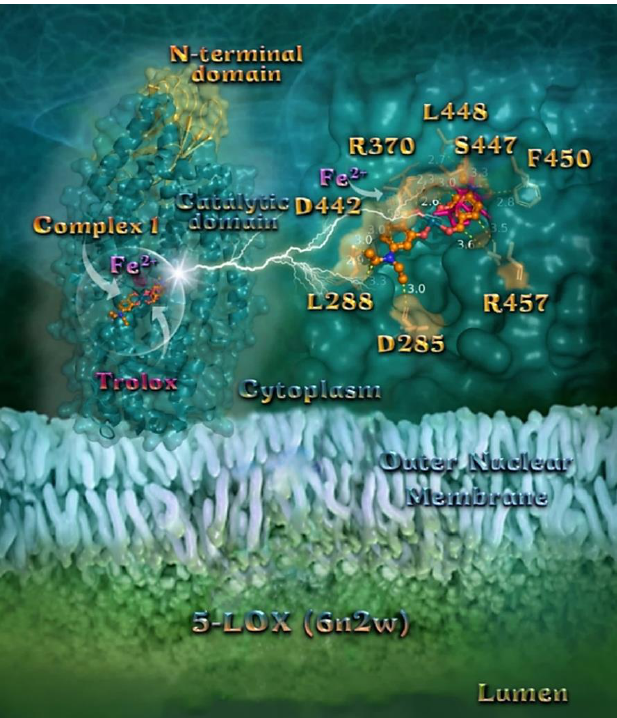
Figure 10. ( Left panel ) Docking pose orientation of complex 1 in the crystal structure of 5-LOX bound with the redox-type inhibitor NDGA (PDB: 6n2w). The target protein is illustrated as a semi-transparent surface in deep teal (catalytic domain) and yellow-orange (N-terminal domain). In superposition are shown the lowest Δ G bind energy binding pose of 1 , as well as the co-crystallized inhibitor NDGA and Trolox, rendered in a ball-and-stick model ( 1 ) and stick (NDGA and Trolox) and colored according to atom type in orange, white, and hot pink C atoms, respectively. Fe 2+ is indicated as a violet dotted sphere. Molecular protein structure is shown to be anchored in the outer nuclear membrane colored in a light blue/green model. ( Right panel ) A close-up view of the binding pocket of 1 in the crystal structure of 5-LOX bound with Trolox (6n2w). The target protein is depicted as a semi-transparent deep teal surface with the additional depiction of selected contacting residues of the binding pocket highlighted in yellow-orange. Complex 1 and Trolox are rendered in ball-and-stick and stick models, respectively, colored ac- cording to atom type in orange and hot pink C atoms, respectively. Molecular docking simulations of all molecules were performed individually. Heteroatom color-code: O: red, N: blue, Cl: char- treuse green, Pd: grey. Hydrogen atoms are omitted from all molecules for clarity. The final struc- ture was ray-traced and illustrated with the aid of PyMol Molecular Graphics Systems. Binding interactions are shown in Table S4.